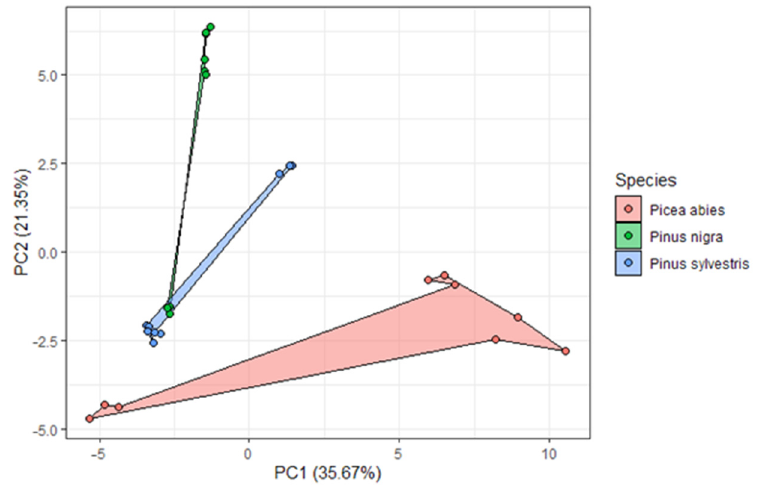
Figure 3. Score plot showing results of the principal component analysis (PCA) performed on the BVOCs content in all of the analyzed genotypes of the three examined species. Dots are representing the position of the obtained results provided in the Supplementary material, for each tested genotype within the investigated species, for three types of the conducted analysis (VOCs determined form fresh herbal material (Headspace-GC/MS 1) and essential oils determined from fresh and dry herbal material (GC/MS Fresh and GC/MS Dry)).